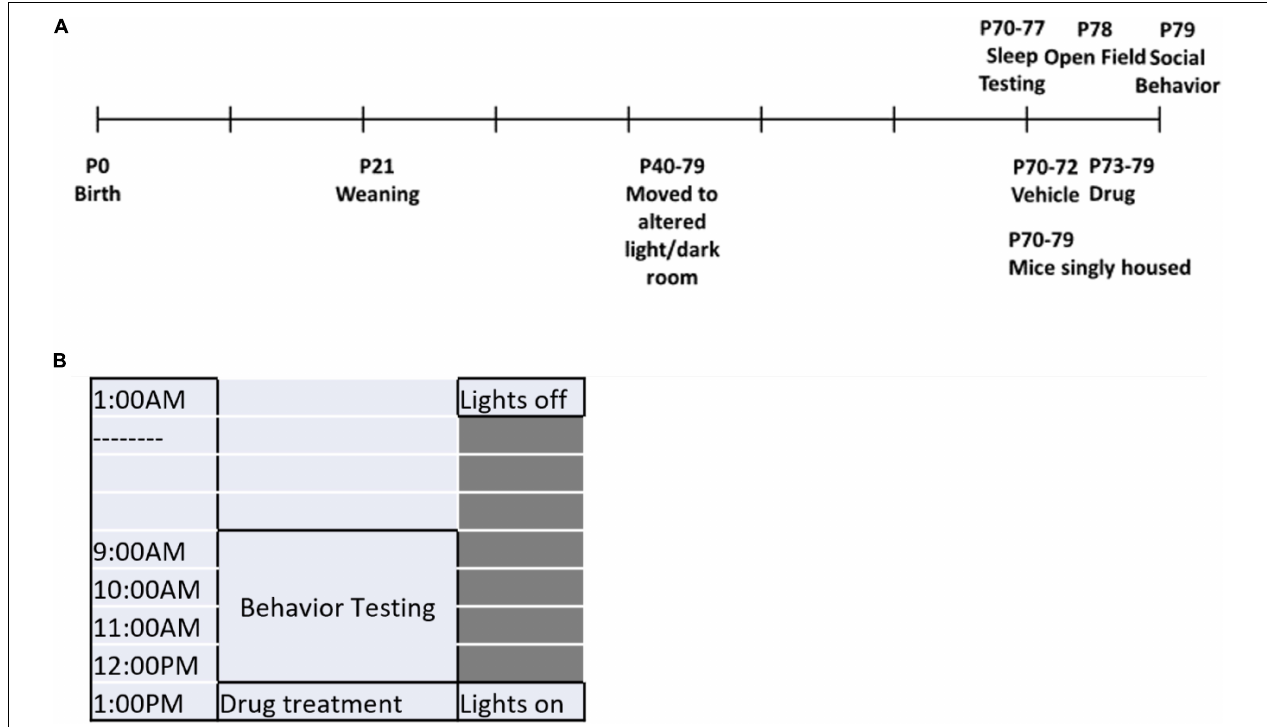
FIGURE 1 | Experimental timeline. (A) The experimental timeline is shown. Mice were moved to the holding room under an altered light/dark cycle beginning at P40 and remained there for the duration of the testing. At P70, mice began sleep testing and the treatment regimen simultaneously (during which time they were also singly housed). From P70-P72, treatment for all mice was the vehicle. At P73-P79, mice were switched to their respective drug treatment groups. Sleep testing ended at P77. Open field testing was conducted on P78 and social behavior testing was conducted on P79. (B) The timeline for behavior testing days is shown. Lights were turned off at 1:00 a.m. Behavior testing occurred from 9:00 a.m. to 1:00 p.m. Hypnotic administration was given at 1:00 p.m. and lights were turned